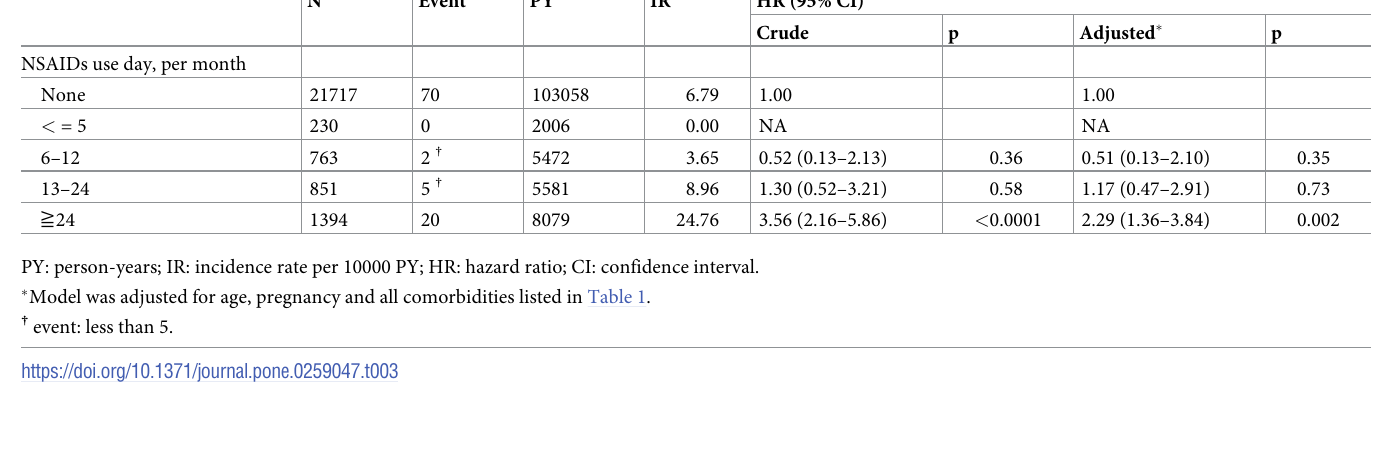
Table 3. Stroke risk seen in women with dysmenorrhea in association with use of NSAIDs and its duration of usage. N